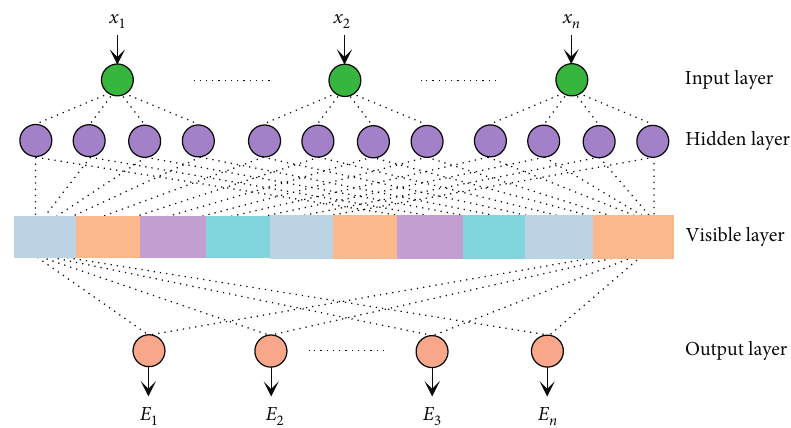
Figure 2: Matching functions construction of children’s psychological distress